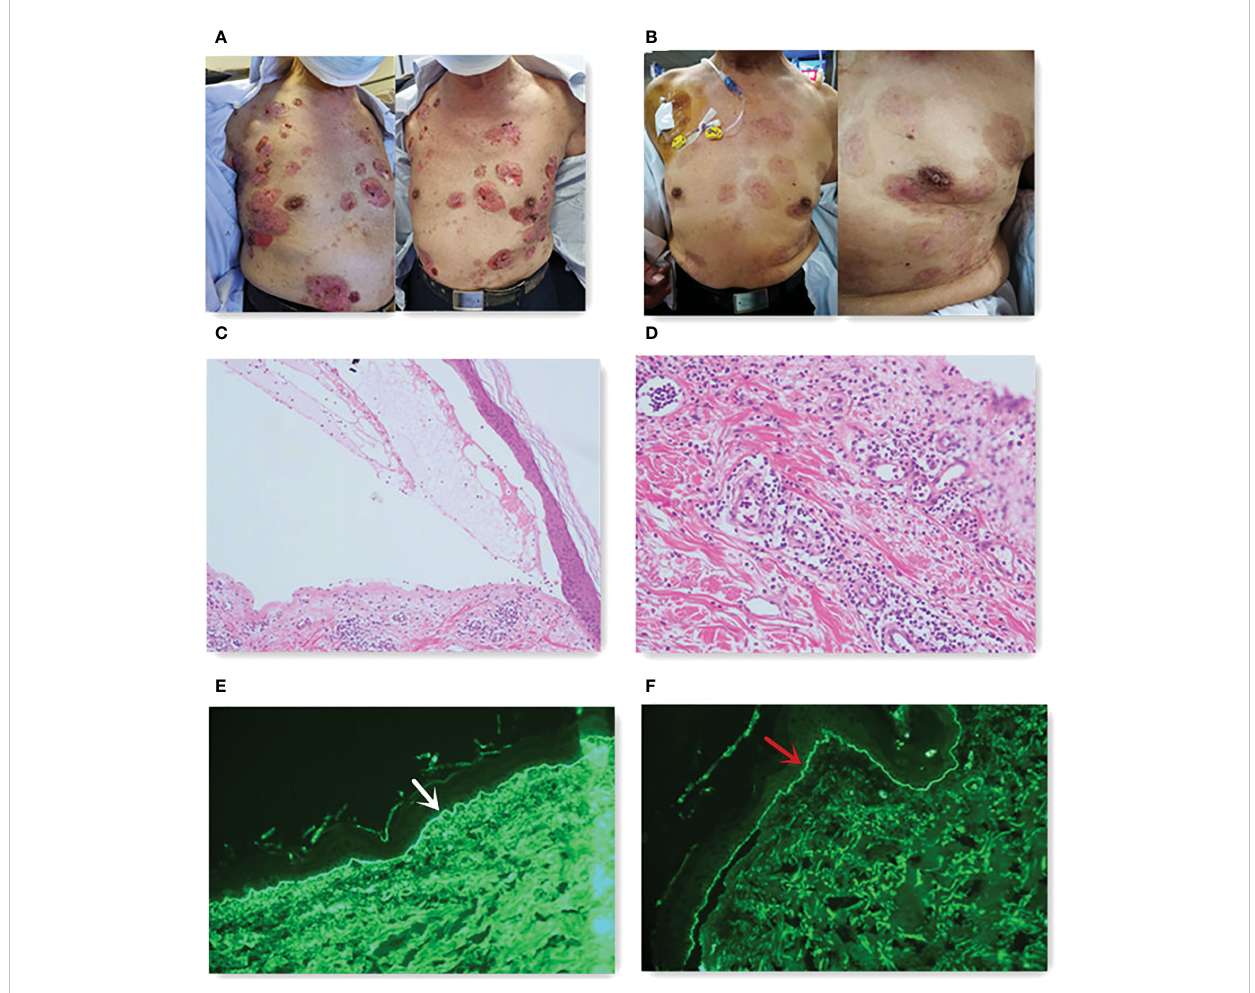
FIGURE 2 (A) Skin lesions before steroids. (B) Skin lesions after 10 months of steroids. (C) Subepidermal blister (hematoxylin and eosin staining, 40×). (D) Eosinophils existed in the blister (hematoxylin and eosin staining, 100×). DIF studies showed linear deposition of C3 [ (E) , white arrow] and IgG [ (F) , red arrow] along the basement membrane